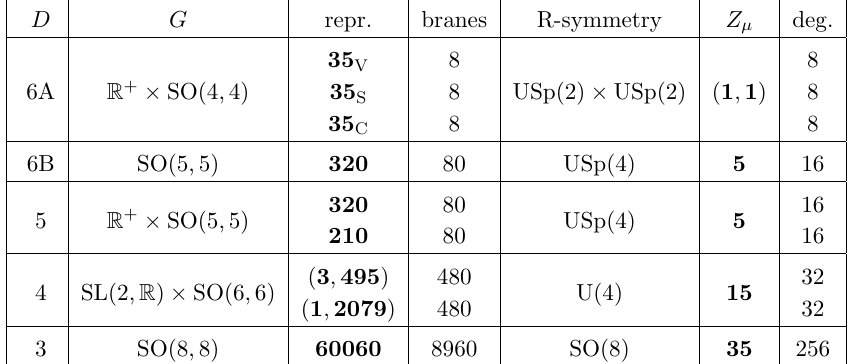
Table 2 . The number and the degeneracy of the 1/2-BPS space-(cid:12)lling branes of the half-maximal theories which arise as Z 2 truncations of the maximal ones [20]. In the 6A theory, 8 of the branes support tensor multiplets and the remaining 16 support hypermultiplets. In the 6B theory the branes support vector multiplets. In (cid:12)ve and four dimensions half of the branes support vector multiplets and the other half support hypermultiplets